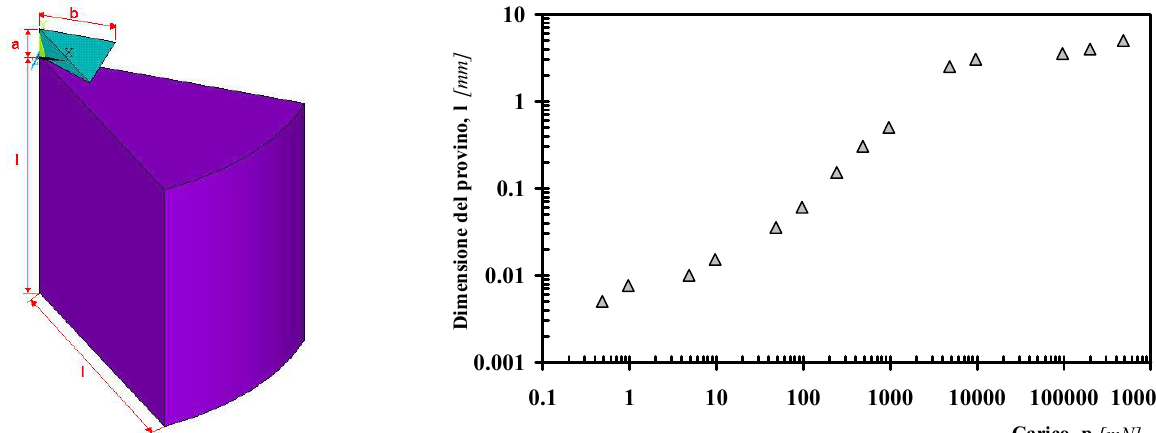
Figura 4: Criterio utilizzato per determinare la dimensione, l, del provino da modellare in ambiente ANSYS® al variare del carico applicato all’indentatore. Figure 4: Definition of dimension l used to do the FE models of the Vickers